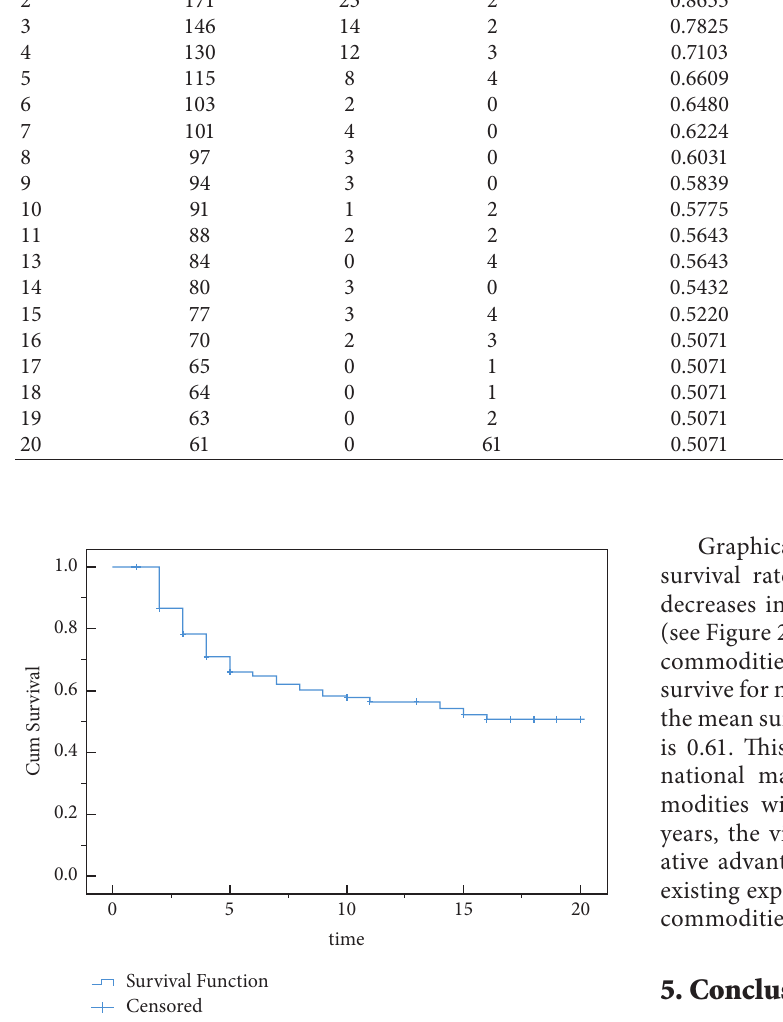
Figure 2: Kaplan–Meier survival analysis of Chinese RSCA index